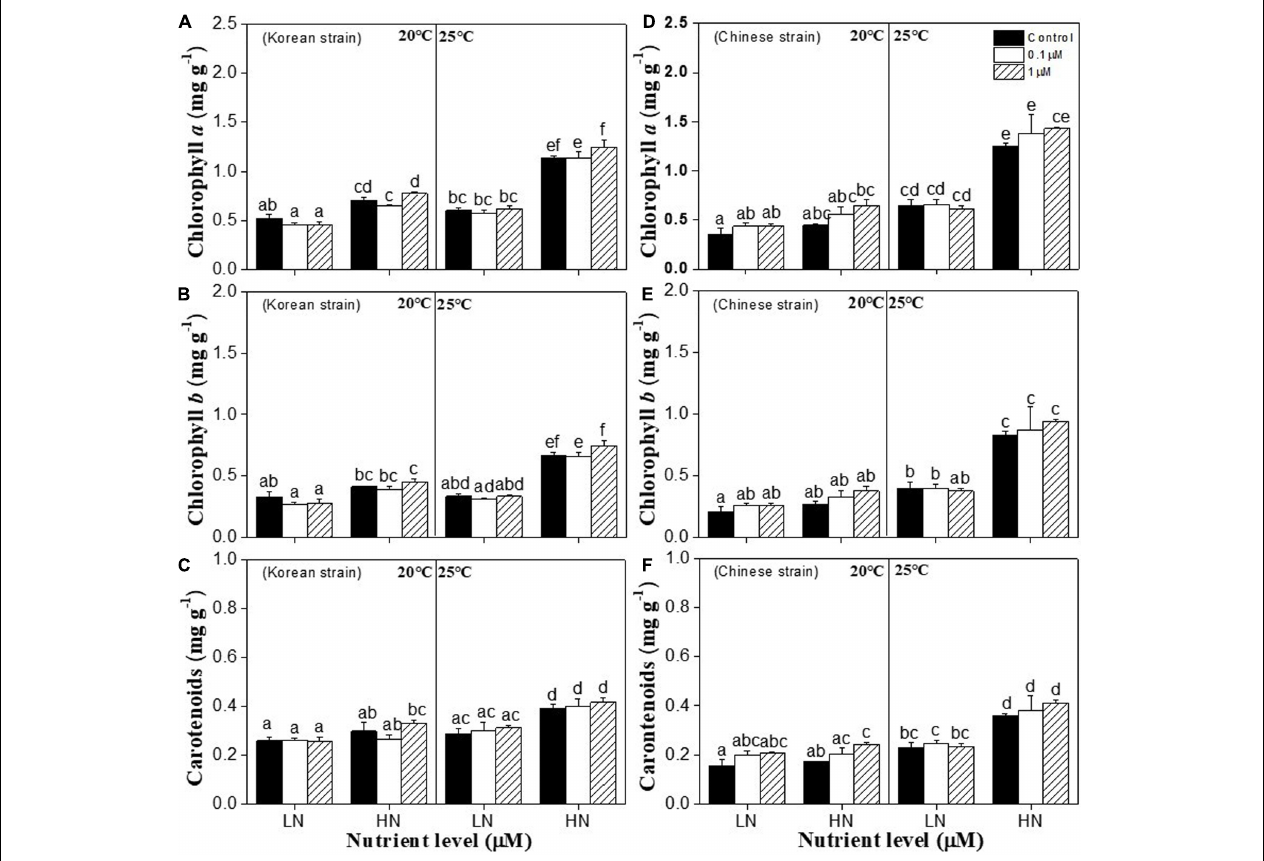
FIGURE 3 | Pigments contents in a Korean strain [Chlorophyll a (A) ; Chlorophyll b (B) ; Carotenoids (C) ] and a Chinese strain [Chlorophyll a (D) ; Chlorophyll b (E) ; Carotenoids (F) ] and of Ulva prolifera cultivated under various experimental conditions. The error bars represent the standard deviation ( n = 3). Low nutrient = 50 µ M nitrate and 5 µ M phosphate (LN); high nutrient = 250 µ M nitrate and 25 µ M phosphate (HN). Different letters above the error bars represent statistical significance ( P < 0.05) among different treatments.